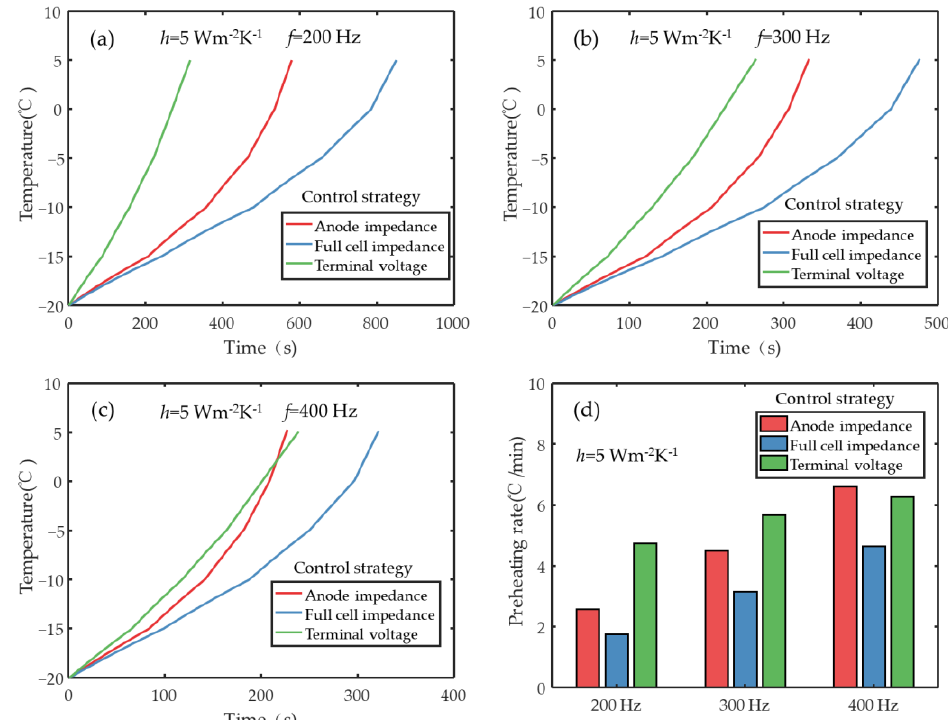
Figure 13. The temperature evolution and the preheating rate of the battery preheated using the methods based on different control strategies; ( a ) the preheating is at the frequency of 200 Hz; ( b ) the preheating is at the frequency of 300 Hz; ( c ) the preheating is at the frequency of 400 Hz; ( d ) the preheating rate of the battery preheated using the methods based on different control strategies, the heat transfer coefficient equals 5 Wm −2 K −1 .